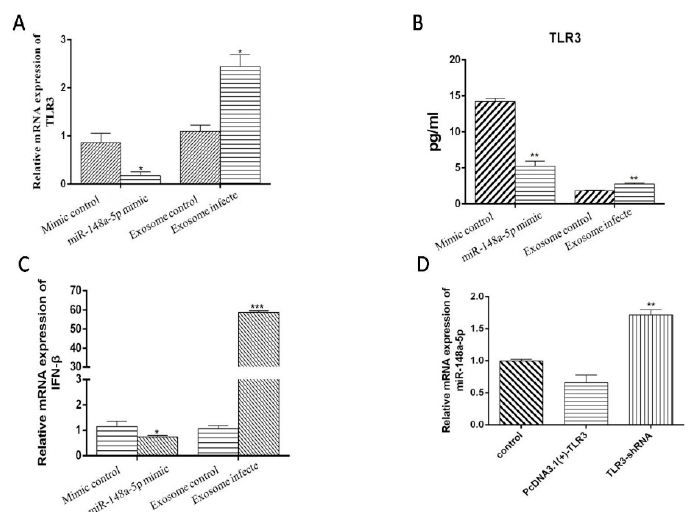
Figure 14. miR-148a-5p and Exo-miR-148a-5p negatively regulates TLR3 and IFN- β expression in PBMCs. After treating PBMCs with miR-148a-5p mimic and control, the mRNA and protein expression of TLR3 decreased ( A , B ), as did the mRNA level of IFN- β ( C ). After treatment of PBMCs with DEF-derived exosomes with or without DTMUV infection, the mRNA and protein expression of TLR3 decreased ( A , B ), as did the mRNA level of IFN- β ( C ). ( D ) DEF cells were treated with pcDNA3.1(+)-NC, pcDNA3.1(+)-TLR3, and TLR3-shRNA for 36 h, after which miRNA-148a-5p expression was determined by qRT-PCR. The results show that TLR3 can suppress miR-148a-5p expression. In ( C ) we set mimic control and exosome control as 1, and in ( D ) we set the control as 1. The error bars represent the SEs. * P < 0.05, ** P < 0.01. Viruses 2020 , 12 , 94